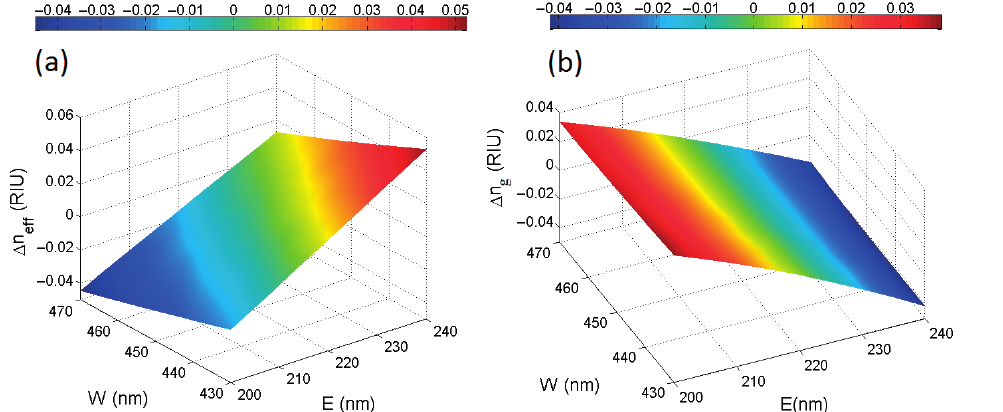
Figure 3. SOI rib waveguide quasi-TE optical mode ( a ) effective and ( b ) group index variations as a function of fabrication tolerances at the operating wavelength of 1.55 μ